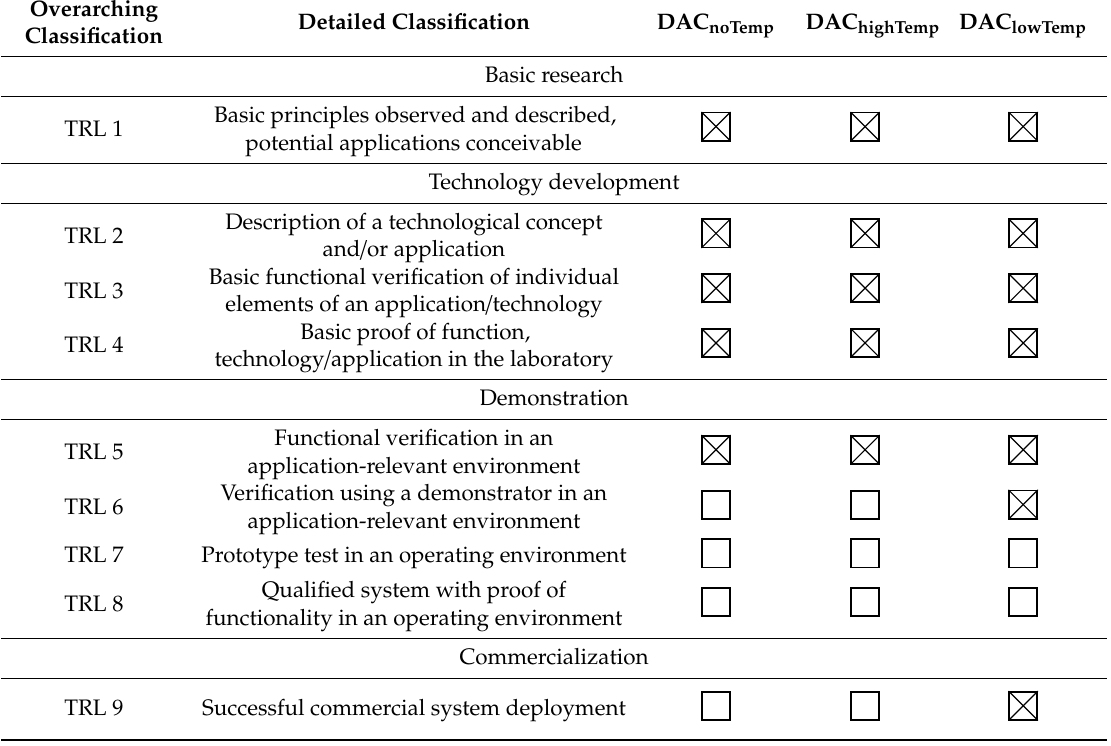
Table 1. Current development stages of Direct Air Capture (DAC) according to their Technology Readiness Level (TRL) (own composition, based on [25,54–57]; boxes are ticked for all TRLs given in the different sources analyzed).